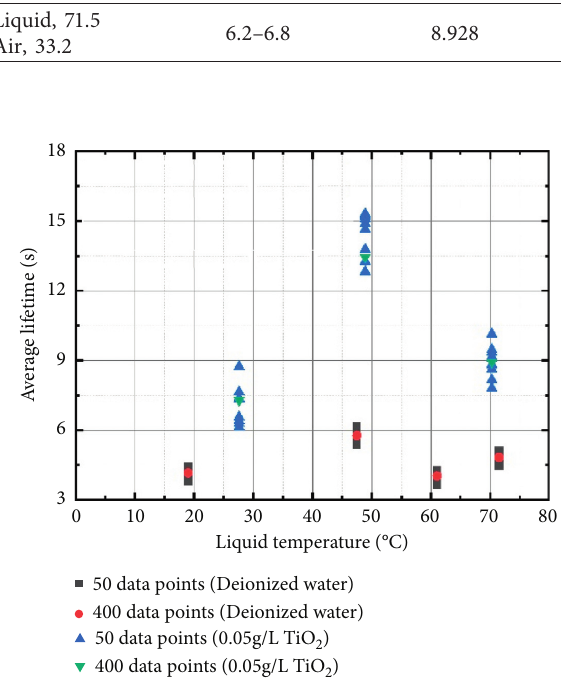
Figure 11: Bubble average lifetime measurement